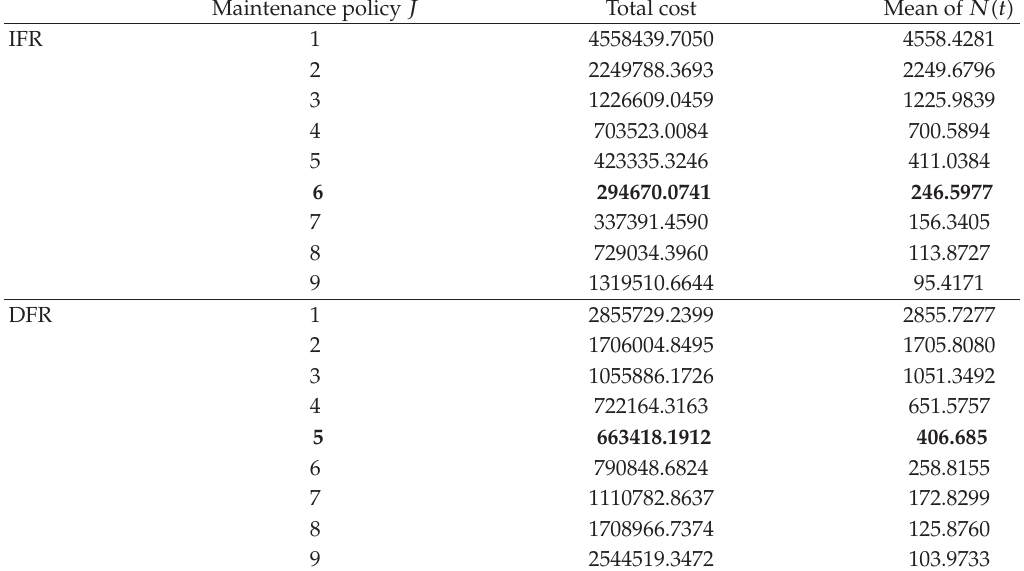
Table 2: Results of the problem of determining optimal maintenance